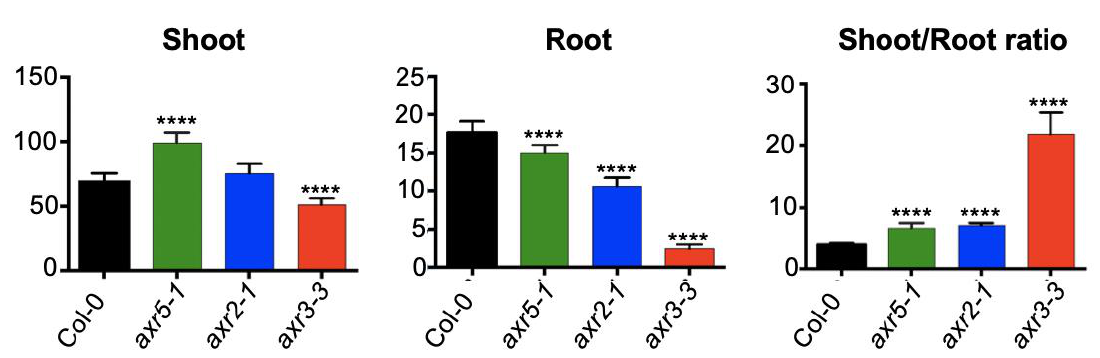
Figure 2. Increased shoot/root growth ratio in Arabidopsis auxin resistant mutants. Nineteen-day-old Col-0 wild type, axr5-1 , axr2-1 , and axr3-3 plants, grown on vertical plates containing half-strength Murashige and Skoog medium, were dissected, and the fresh weights of shoots and roots were measured. Data are presented as mean ± SD (n ≥ 12 pools of 8 plants each). The significance of the difference between the wild type and the mutants is noted (****, p < 0.0001; two-way ANOVA with Bonferroni’s multiple comparisons test) Kurepa et al., unpublished